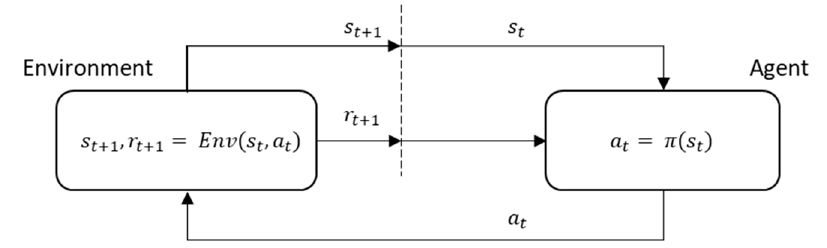
Figure 5. Agent–environment interaction in the Markov decision process (MDP).